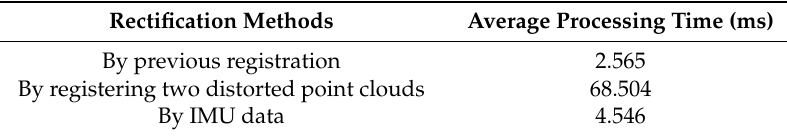
Table 1. Computational efficiency of three rectification methods.